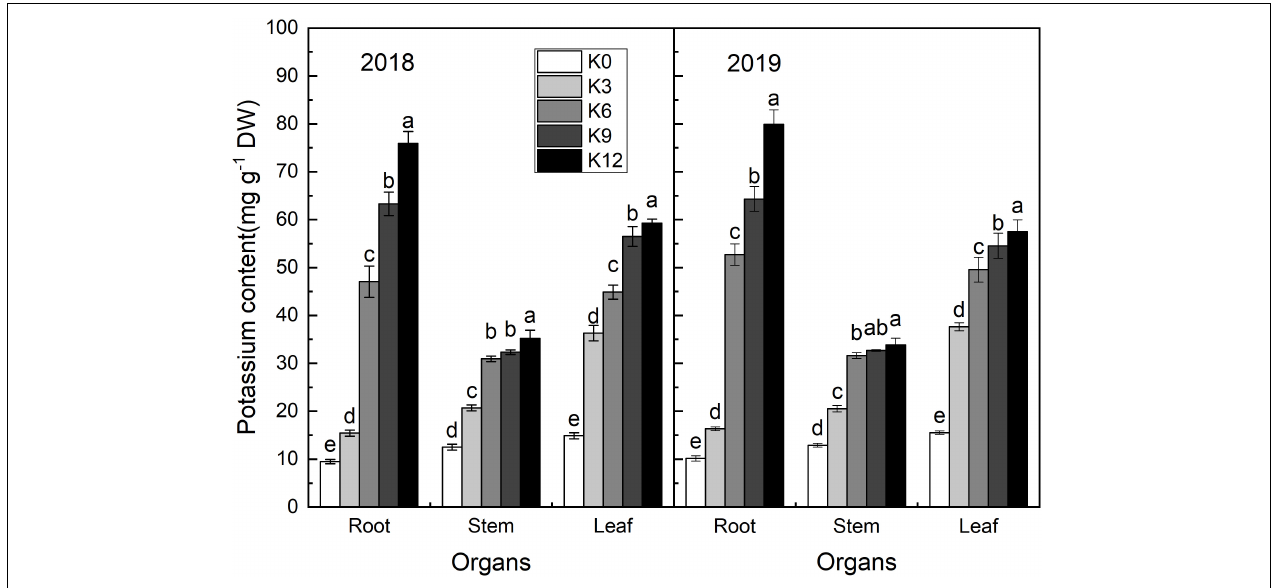
FIGURE 2 | K concentrations (mg g − 1 DW) in the leaves, stems, and roots of M9T337 seedlings treated with K0 (0 mM K + ), K3 (3 mM K + ), K6 (6 mM K + ), K9 (9 mM K + ), or K12 (12 mM K + ) in 2018 and 2019. Each treatment had three biological replicates and the assays were repeated three times. Vertical bars indicate ± SD ( N = 3). Different letters indicate statistically significant differences ( P < 0.05). TABLE 3 | Photosynthetic Parameters and chlorophyll fluorescence of M9T337 seedlings treated with K0 (0 mM K + ), K3 (3 mM K + ), K6 (6 mM K + ), K9 (9 mM K + ), or K12 (12 mM K + ) in 2018 and 2019. Year